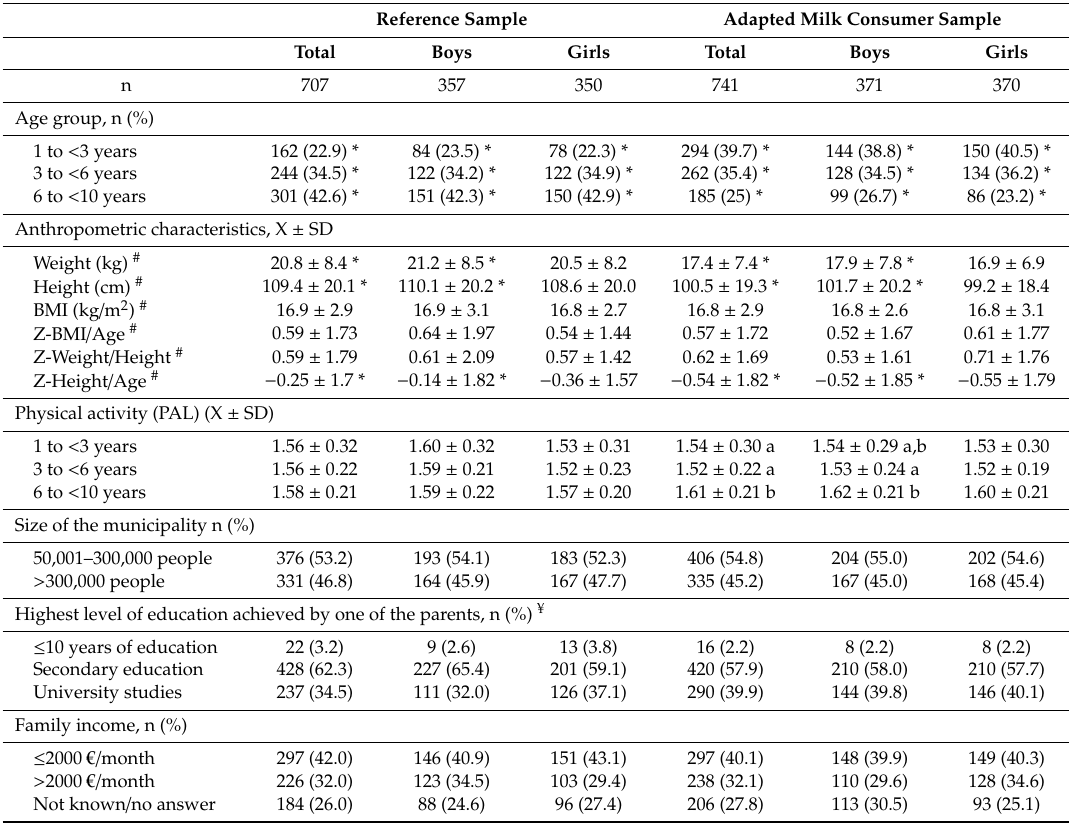
Table 1. General, anthropometric, and socioeconomic data by sex and age group in the Estudio Nutricional en Poblaci ó n Infantil Española (EsNuPI) population. Di ff erences between reference sample and adapted milk consumer sample ( n =